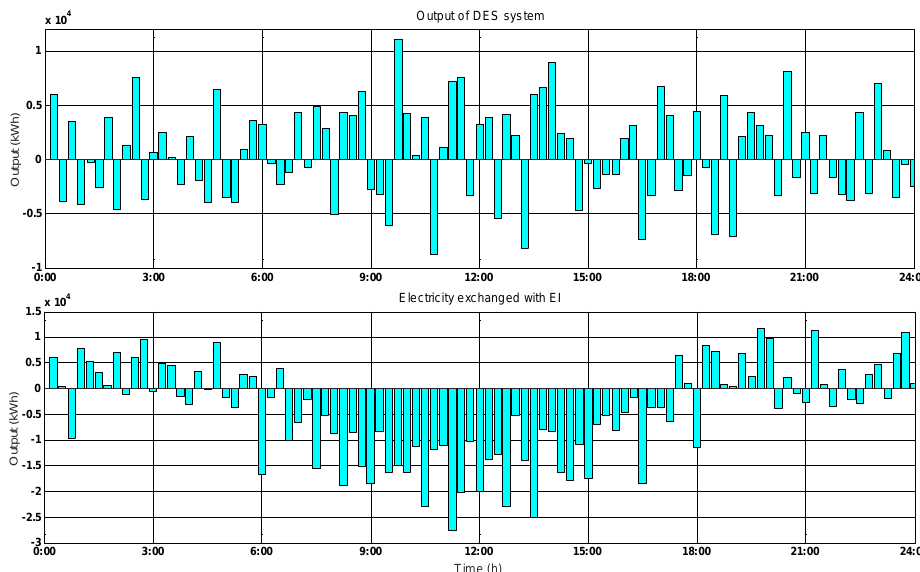
Figure 9. The output power of the DES system and electricity exchanged with EI in Scenario Two.